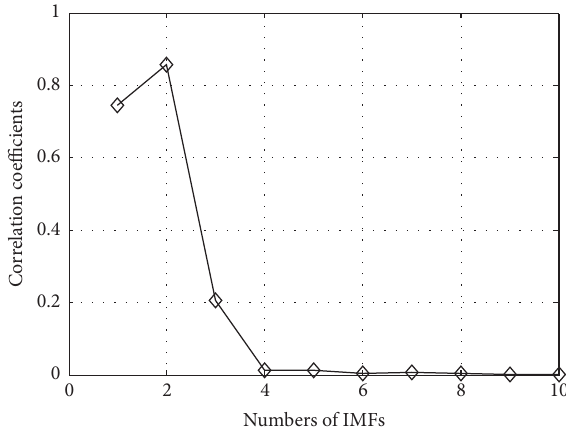
Figure 6: Correlation coefficients between each IMF and the sample signal.